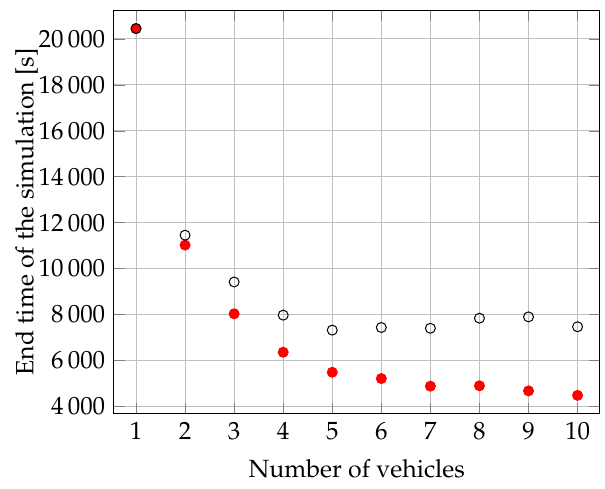
Figure 4. A comparison of the results for bidirectional paths. The empty circles present results for the original SOCP method while the red circles show the results of this method using the deadlock-free zones shown schematically in Figure 1b. The use of the new type of zone allowed for a significant reduction in transport task completion times of up to 40%, which is due to the reduction in the restrictiveness of the method by segmenting the guided